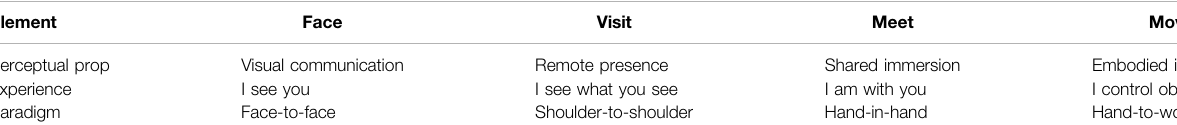
TABLE 1 | Fundamental elements of an immersive communication system. Element